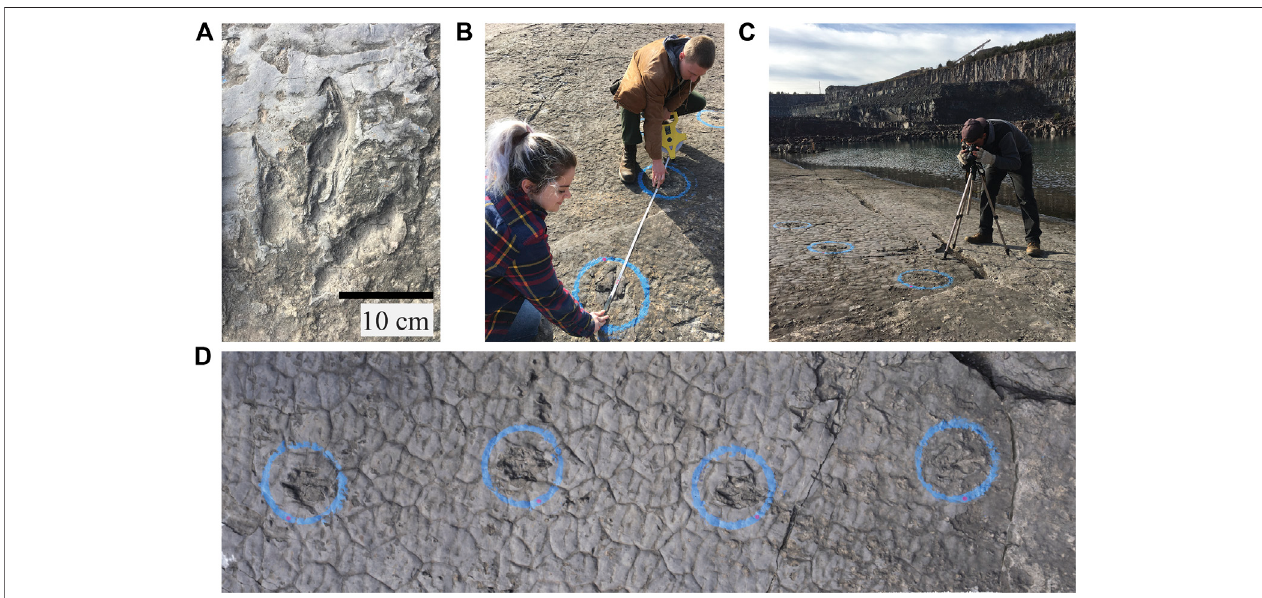
FIGURE 5 | The photogrammetric process of capturing 3D digital surfaces of in situ fossil footprints (sourced from original publication; Ziegler et al., 2017) (A) Exampleofafootprintofthedinosaurichnotaxon Kayentapusminor attheLuckstoneQuarry,partoftheK15trackway (B) ,Measurementsareneededtosetthescaleof the digital model and verify its accuracy. They also need to be easily found, so adding colorful stickers can make this simpler; Caroline Abbott (bottom); Mark Simonds (top) (C) , About 70 well-focused, high-resolution photos need to be taken of each track in a full 360 o circle, from multiple angles, including the connecting rock between them; Michael Ziegler (D) The images can then be compiled into a 3D mesh in the software Agisoft Photoscan , which can then be uploaded to Sketchfab and made freely available and used for K – 12 education.